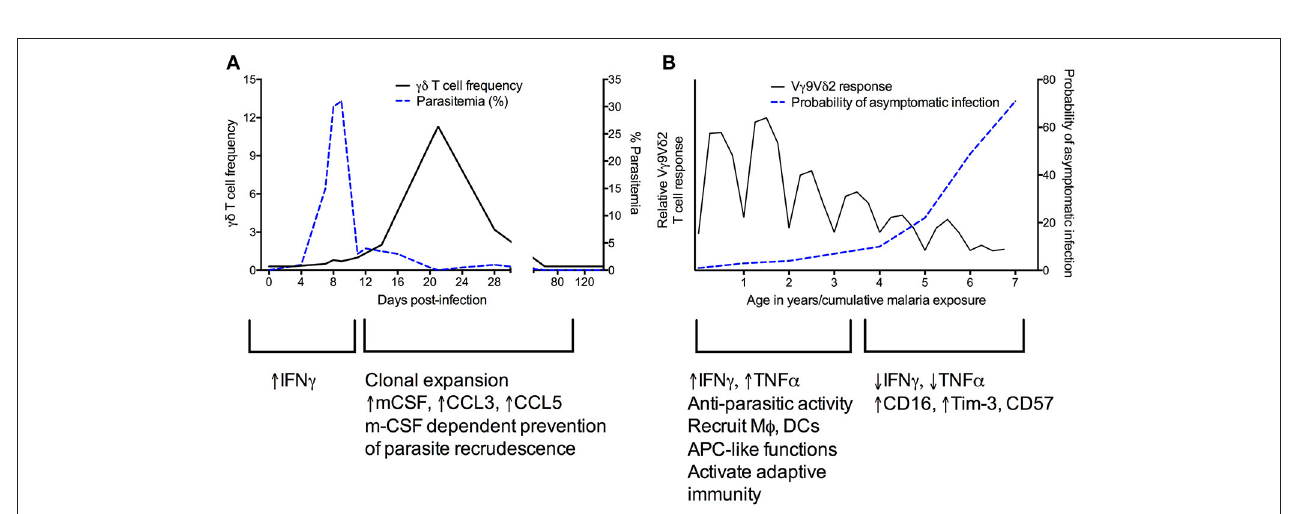
FIGURE 2 | Kinetics of γδ T cell responses during murine Plasmodium chabaudi (A) and recurrent human Plasmodium falciparum (B) infections. (A) [adapted from Figures 1A,E in Mamedov et al. (9)]. During the acute phase of P. chabaudi infection, γδ T cells primarily produce IFN γ . Proliferation of γδ T cells later in infection corresponds with increased production of cytokines such as M-CSF that influence the myeloid compartment, and in parallel, a decrease in parasitemia. (B) In human malaria, V γ 9V δ 2T cells rapidly proliferate and produce pro-inflammatory cytokines during primary P. falciparum infection. These cells recruit and activate other immune cells and are able to kill parasites. After repeated infections, V γ 9V δ 2T cells proliferate less and produce less IFN γ and TNF α while increasing expression of CD16 and regulatory markers such as Tim-3 (34, 35, 39). These changes correlate with an increased probability of asymptomatic